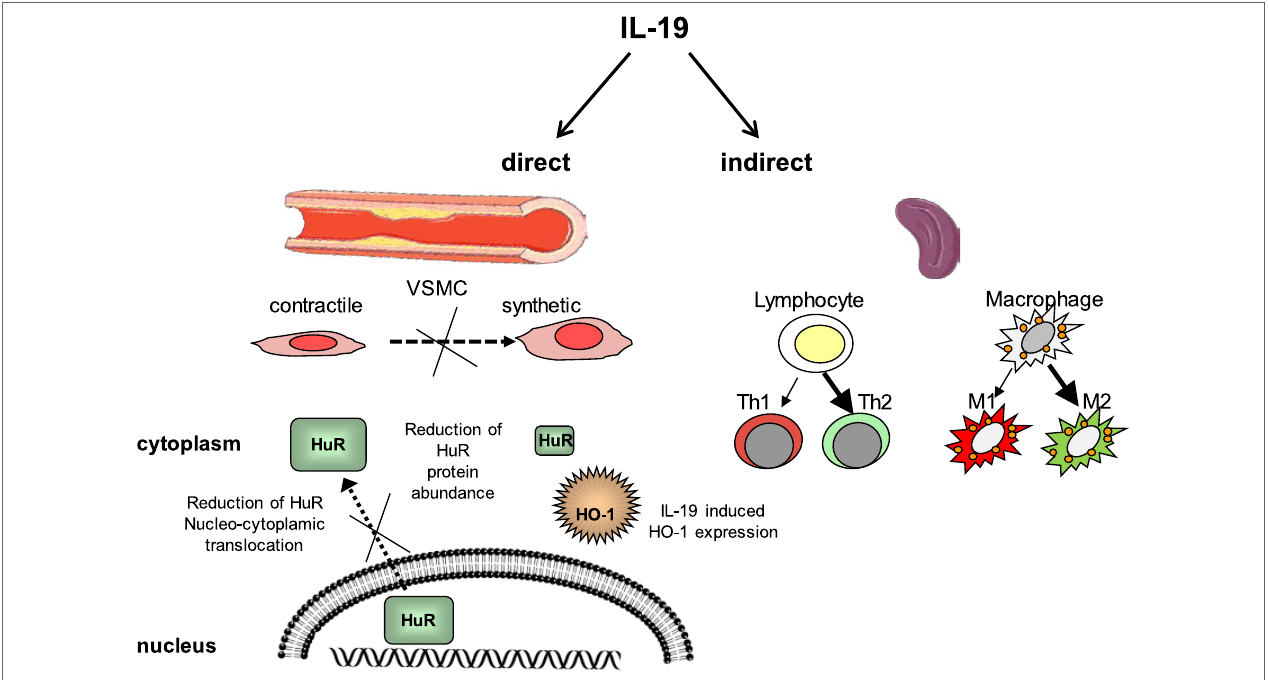
FigURe 2 | Interleukin-19 (IL-19) has direct and indirect vasculo-protective effects. IL-19 reduces VSMC inflammation and proliferation by reduction of HuR nucleocytoplasmic translocation and reduction of HuR protein abundance. HuR also protects VSMC by the induction of hemeoxygenase-1 expression. IL-19 polarizes T lymphocytes to the Th2 and macrophage to the M2 phenotype, each skewed toward anti-inflammatory and reparative characteristics. Together, this results in less pro-inflammatory and proliferative gene expression, resulting in reduced vascular inflammation. HO-1, Heme oxygenase-1, HuR, Human antigen R, VSMC, vascular smooth muscle